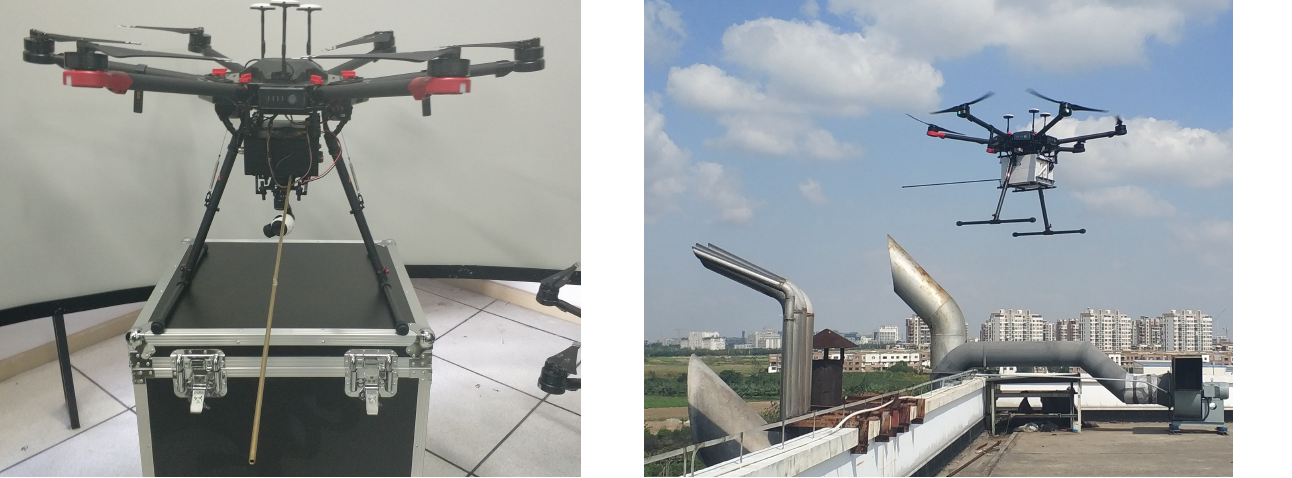
Figure 1. Image of the modified UAV platform. The black box in- stalled under the UAV is a pod which was designed and customized by us. It carries a gas pump (to collect the ship’s exhaust gas), gas circuit, a filter (to remove water vapor), sensors for SO 2 and CO 2 , a small motor (to provide energy for pumping), a camera, and com- munication modules.